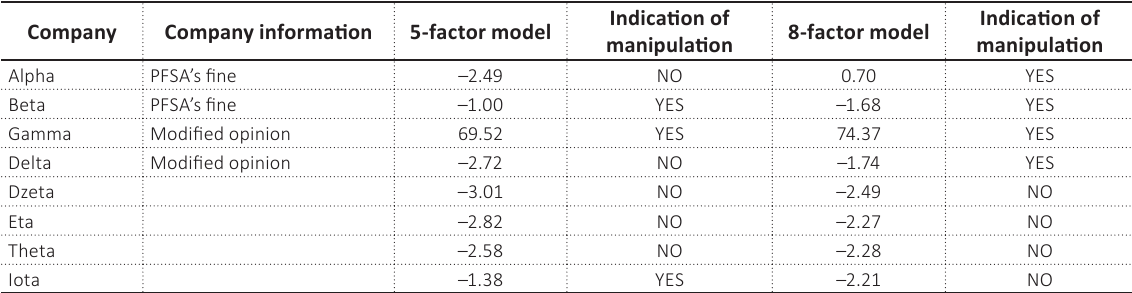
Table 5. Aggregate values using 5-factor and 8-factor models for the analyzed companies Company Company information 5-factor model Indication of